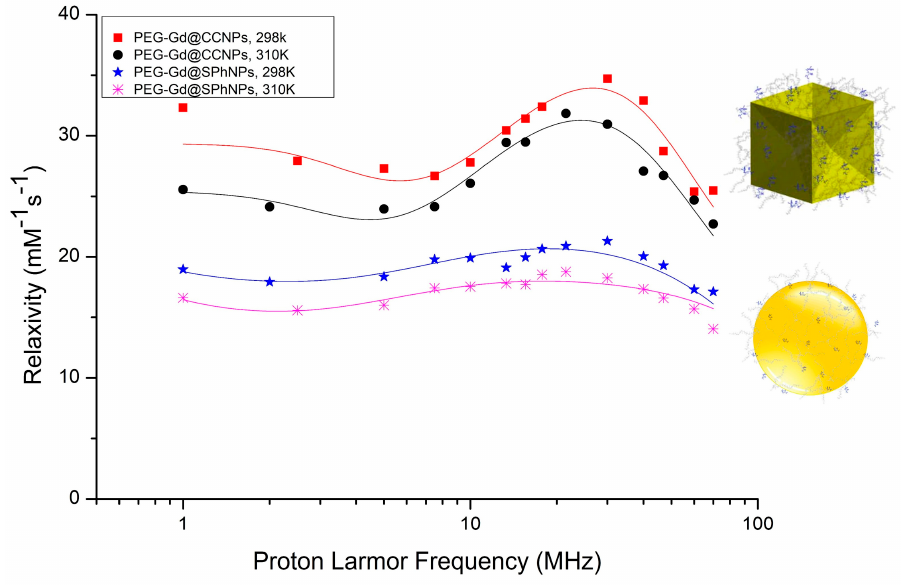
Figure 6. NMRD profile of concave cube and spherical gold nanoparticles at 298 K and 310 K.